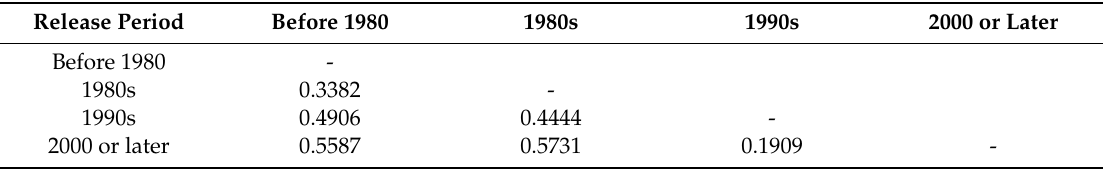
Table 7. Genetic distance between all pairings of group by release period based on SSR